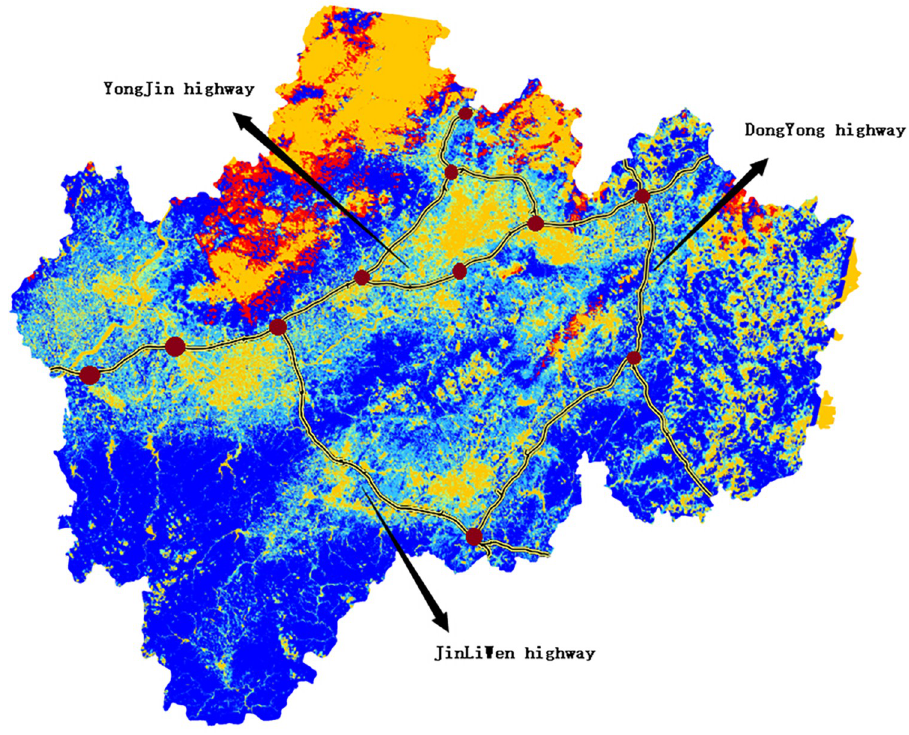
Fig 2. Schematic diagram of the study